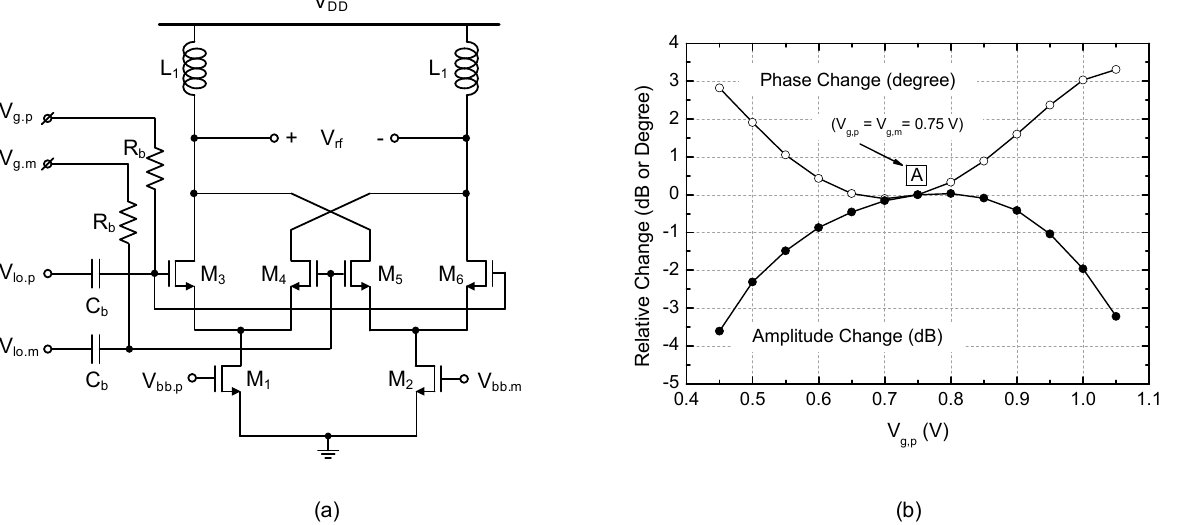
Figure 6. Effect of the gate bias voltage control on the output signal in a single Gilbert-cell mixer. ( a ) Schematic; ( b ) Relative change of the amplitude and phase at the mixer’s output signal with respect to the gate bias voltage of the switching FET.